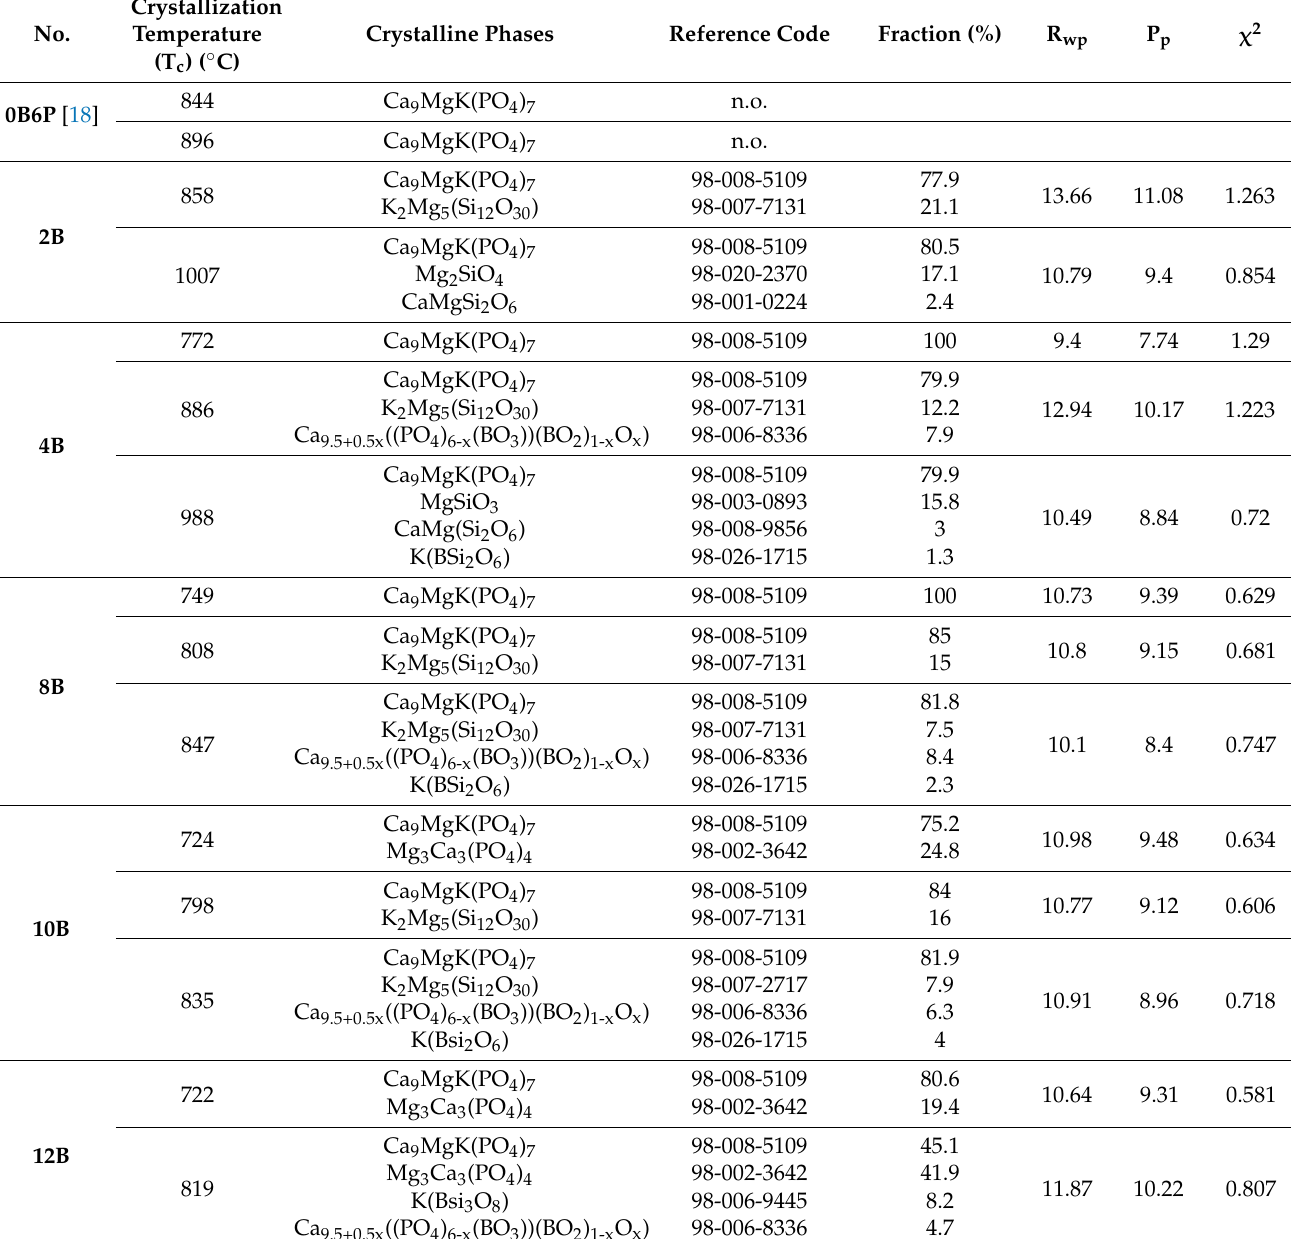
Table 3. The kind of crystallizing phases identified in the analyzed devitrificates. Refined evaluation parameters used for the analysis are also